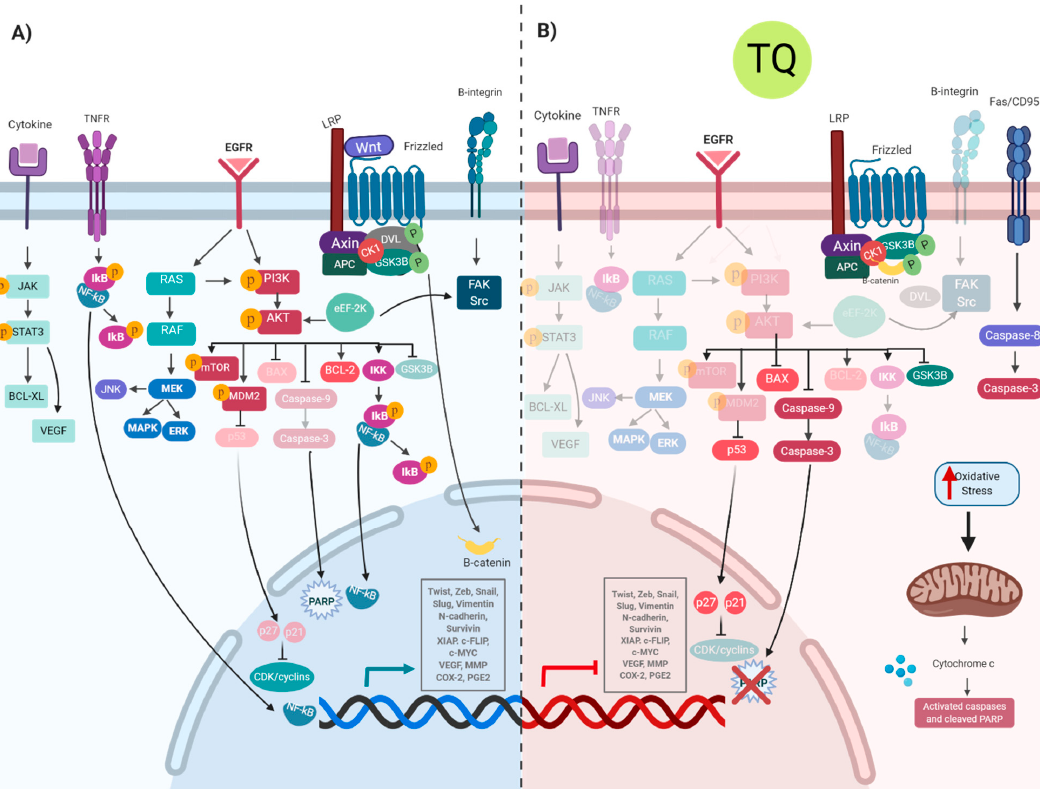
Figure 1. Molecular mechanisms of TQ in cancer development ( A ) pathways involved in cancer development; ( B ) path- ways inhibited by TQ that appear transparent in the figure while opaque molecules are activated.